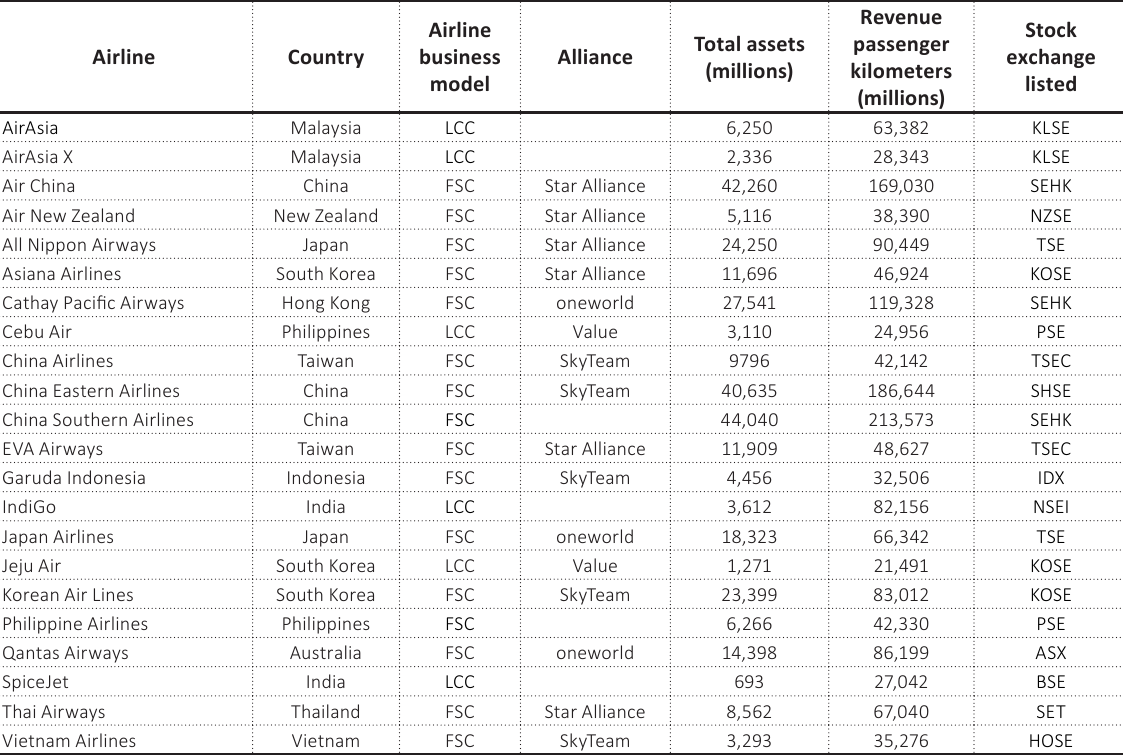
Table 1. Background information on airlines in the Asia-Pacific region Source: IATA World Air Transport Statistics, Plus Edition 2020, and the websites of the respective airline alliances and airline companies.